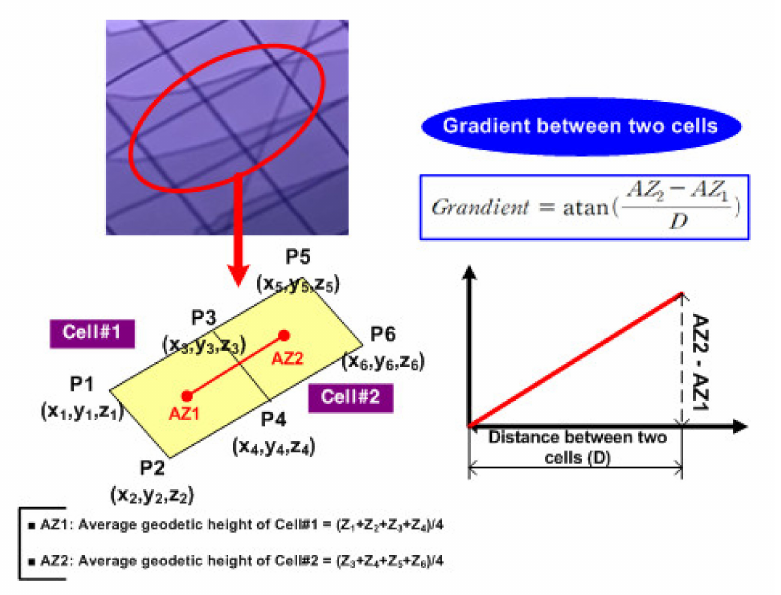
Figure 7. Gradient